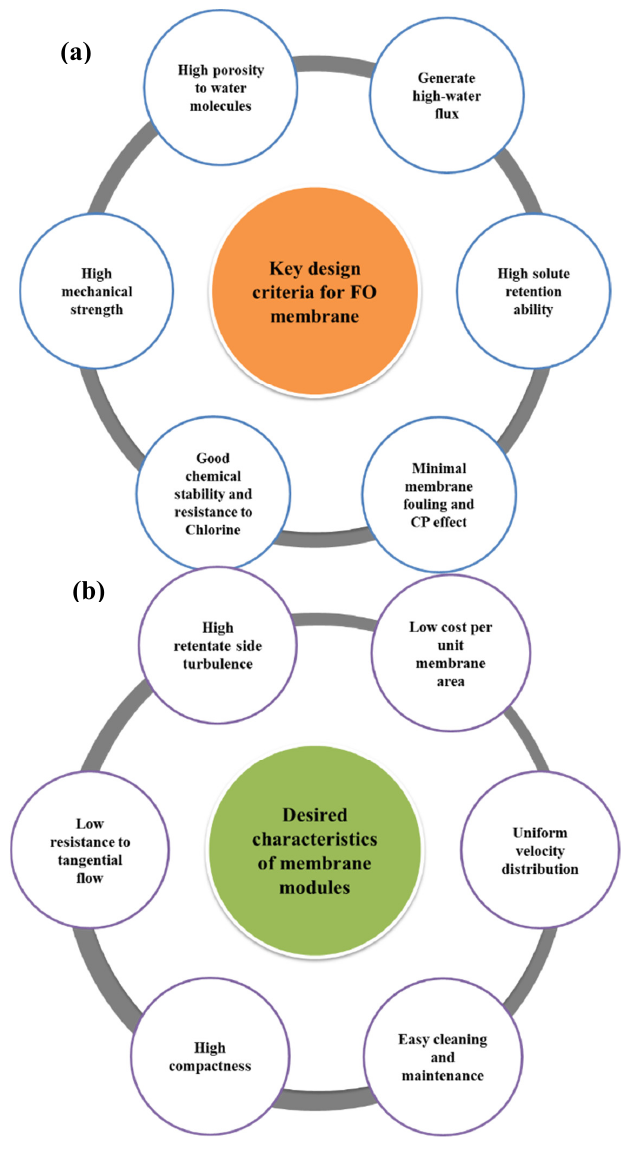
Figure11. ( a )KeydesigncriteriaforFOmembranesand( b Figure 11. ( a ) Key design criteria for FO membranes and ( b ) key desired characteristics of membrane modules.